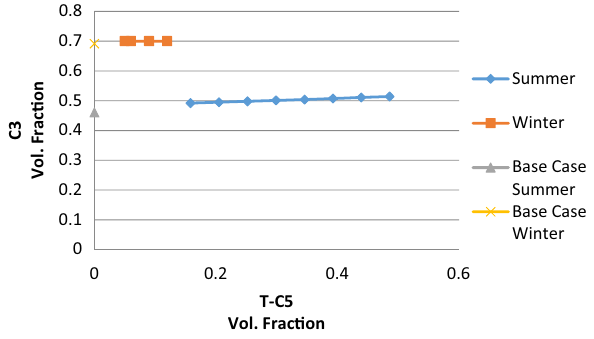
Fig. 31 Limitation of adding i-C5 to 20 vol% DME and